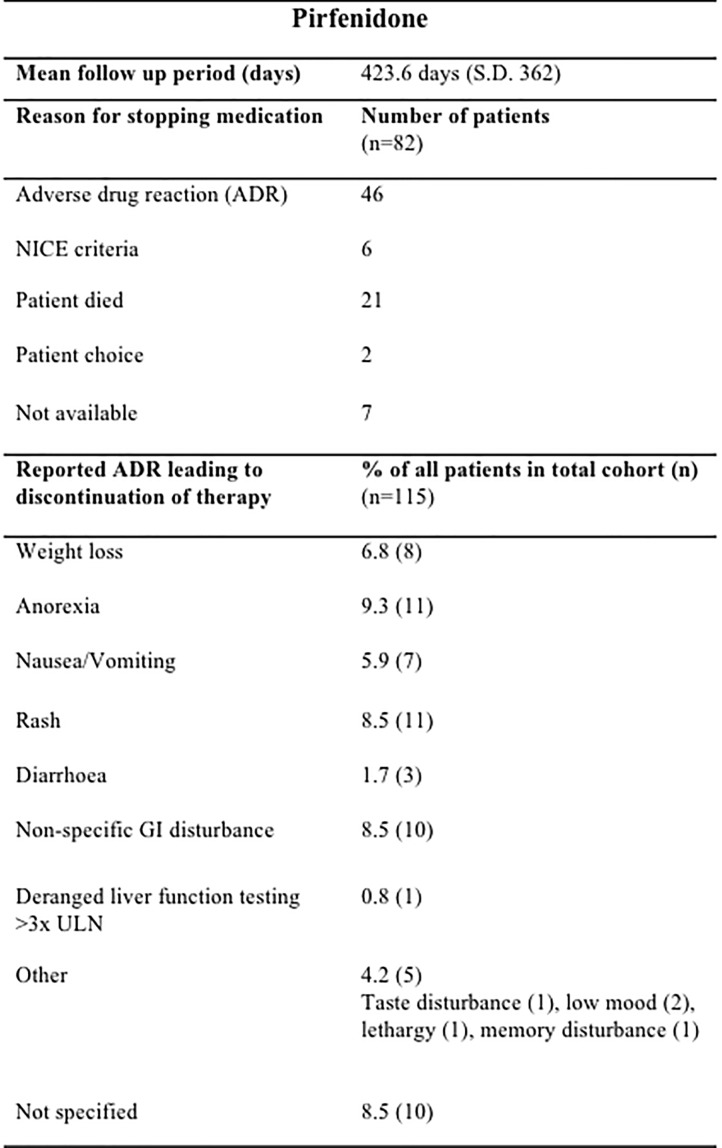
Documented reasons for cessation of Pirfenidone therapy during the study with a mean duration of follow up of 423.6 days (SD 362). In the cohort studied, 82/115 patients terminated therapy, most commonly due to ADRs (46/82), whilst fulfillment of NICE criteria for disease progression [National Institute for Health and Care excellence (NICE) criteria for stopping medication (National Institute for Health and Care Excellence, 2013): anti-fibrotic medication has to be stopped where there is disease progression as evidenced by a decline in percent predicted FVC of 10% or more within any 12 months period] 6/82, patient choice 2/82 and death 21/82 were also documented reasons. Anorexia (15 ADRs), rash (11ADRs) and GI disturbance (10 ADRs) were the most commonly reported ADRs leading to discontinuation of pirfenidone in our cohort. n, number; GI, gastrointestinal; ULN, upper limit of normal; GORD, gastro-oesophageal reflux disease; URTI, upper respiratory tract infection.